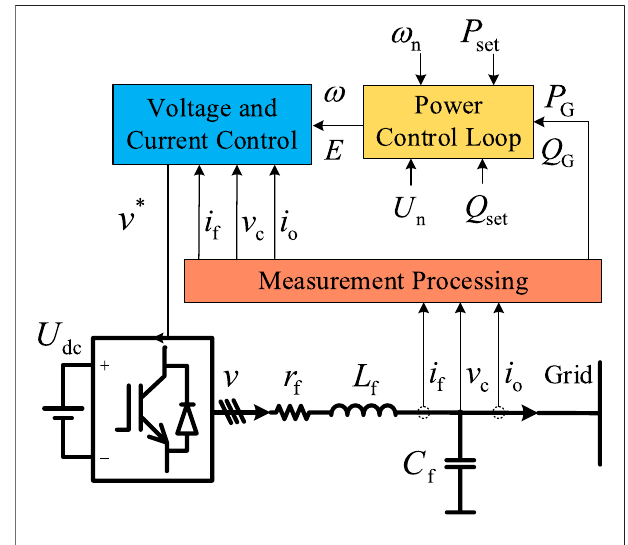
FIGURE 1 | Diagram of a GFM